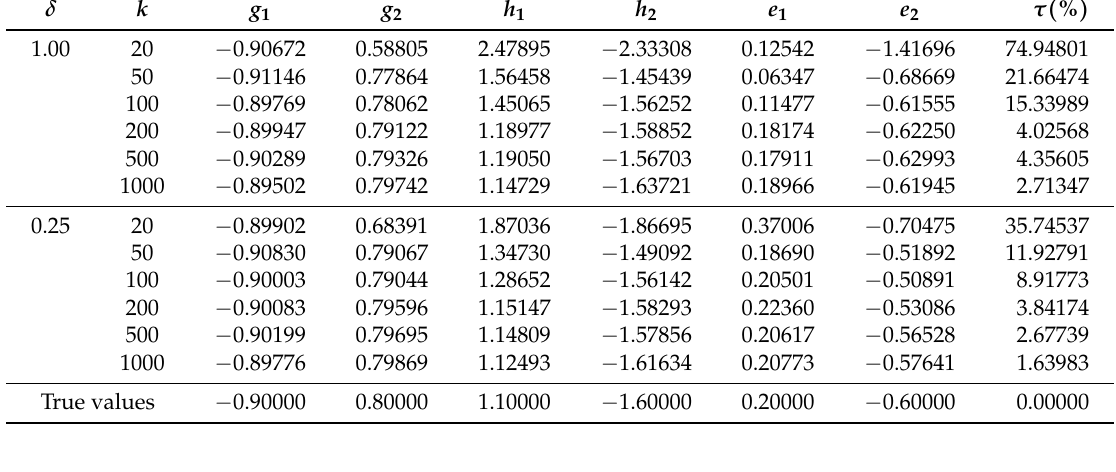
Table 2. The bias compensation-based parameter estimates and errors for Example 1.